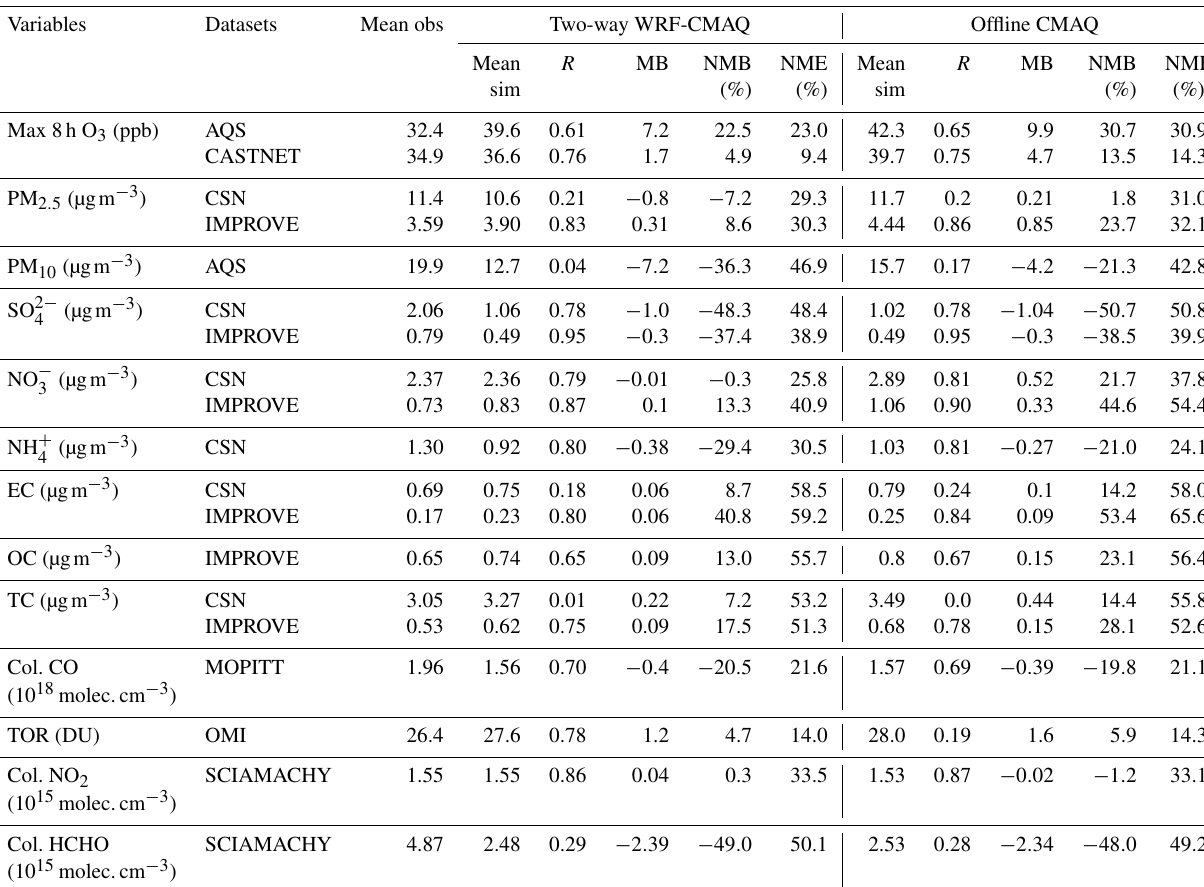
Table 3. The 5-year average performance statistics for chemical variables between two-way WRF-CMAQ and offline CMAQ simulations in winter 2008–2012.